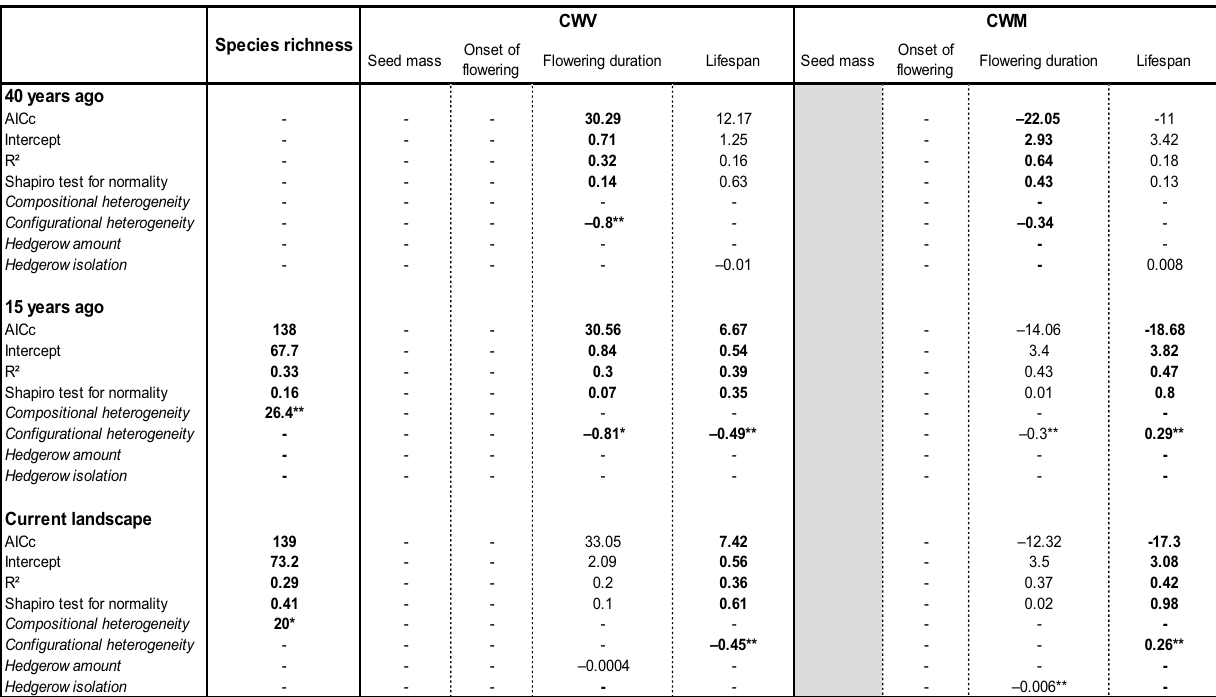
Table 2. Results of linear models testing the effect of landscape predictors on species richness, community weighted variance (CWV) and community weighted mean (CWM) of each trait, calculated from the occurrence rate of plant assemblages in hedgerows. AICc, intercept, R 2 and Shapito test for normality of residuals of each significant model are indicated. Estimates of the landscape predictors and their significance levels (***p < 0.001, **p < 0.01, *p < 0.05) are indicated. Non-significance of models and landscape predictors (–) are indicated. Selected best-fitting models meeting the conditions of lowest AICc (ΔAICc < 2) and normal residuals are indicated by bold font. Models in normal font are included to illustrate the ΔAICc between significant models. The trait ‘allocation to clonal reproduction’ was not considered because the CWVs were found randomly distributed with the null model NM2. The trait ‘seed mass’ in the CWM section is colored in grey because CWMs for this trait were not calculated as the CWV was found divergent with the null model NM2.